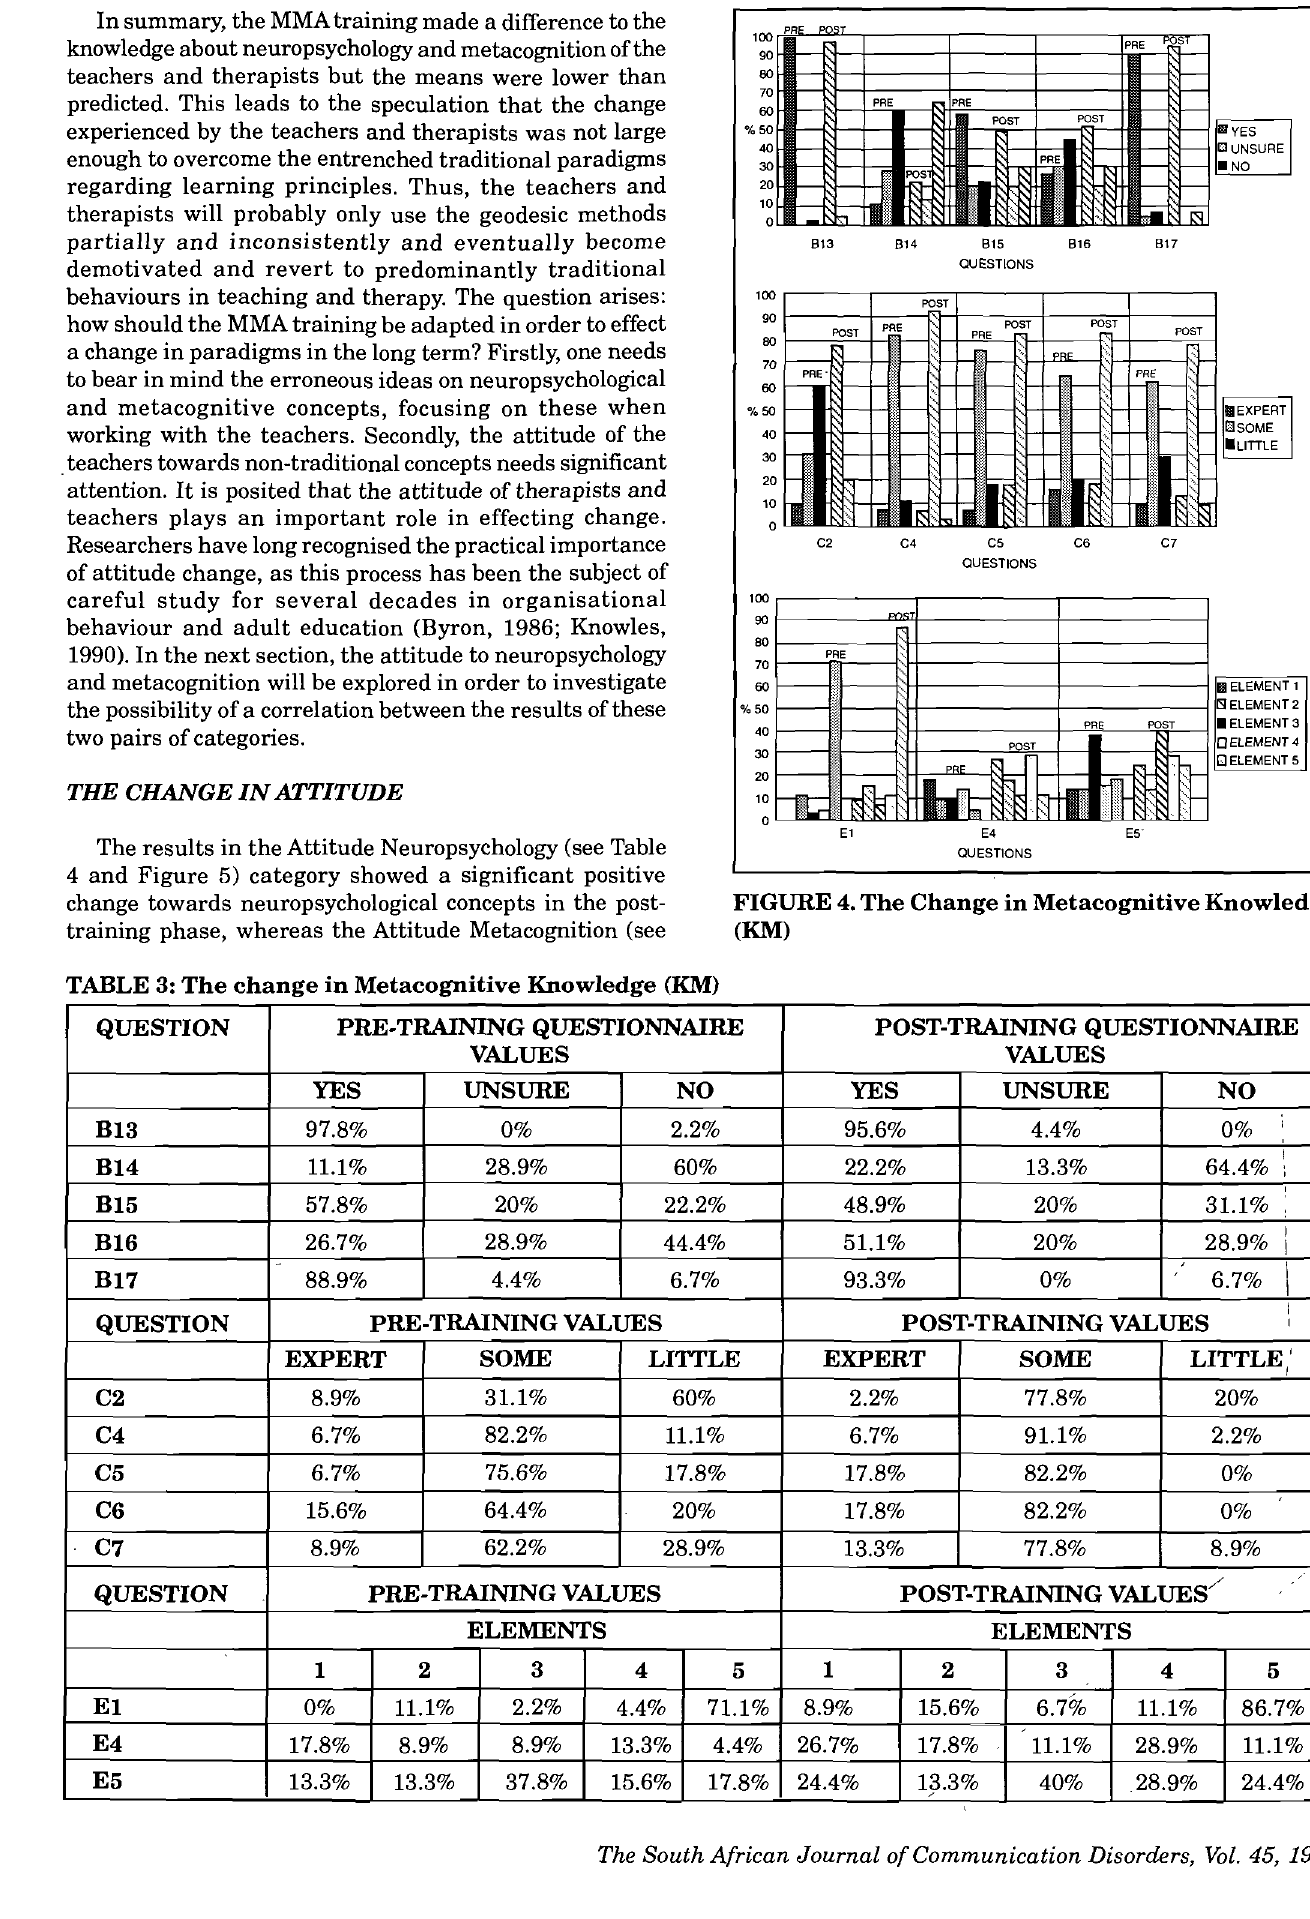
FIGURE 4. The Change in Metacognitive Knowledge (KM)